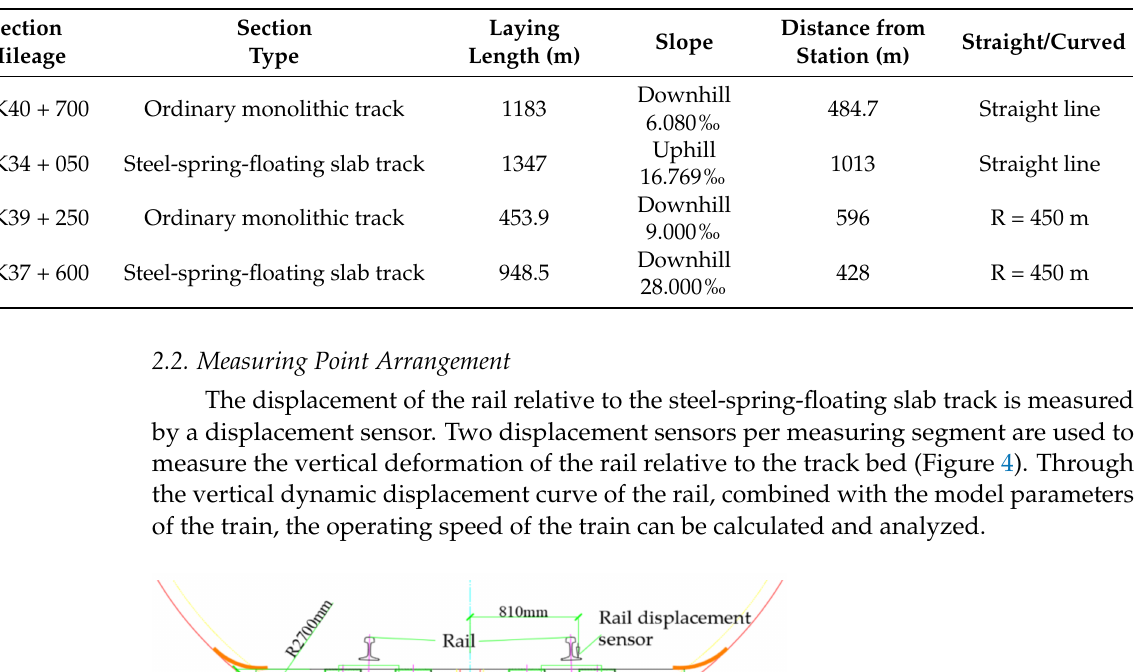
Table 1. Test section overview (steel-spring-floating slab track and ordinary monolithic track).